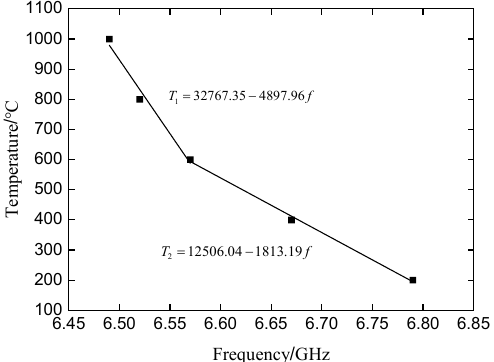
Figure 6. ( a ) Relation between resonant frequency and dielectric constant. ( b ) Relationship between dielectric constant and temperature.